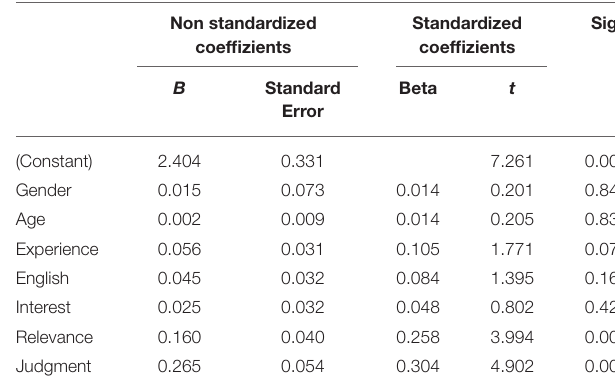
TABLE 6 | Linear regression model predicting the score on “Sustainability” from the UN-scale in the Indian sample.